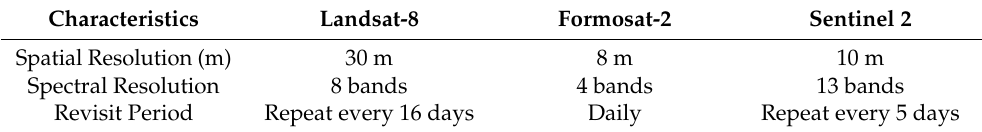
Table 1. Specification of Landsat-8, Formosat-2, and Sentinel-2 [36,37]. Characteristics